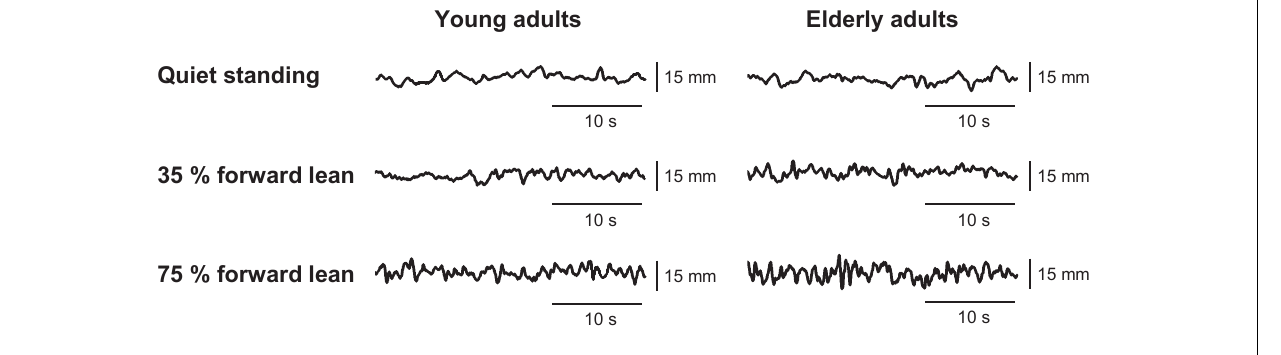
independent, and one indicates that two signals are